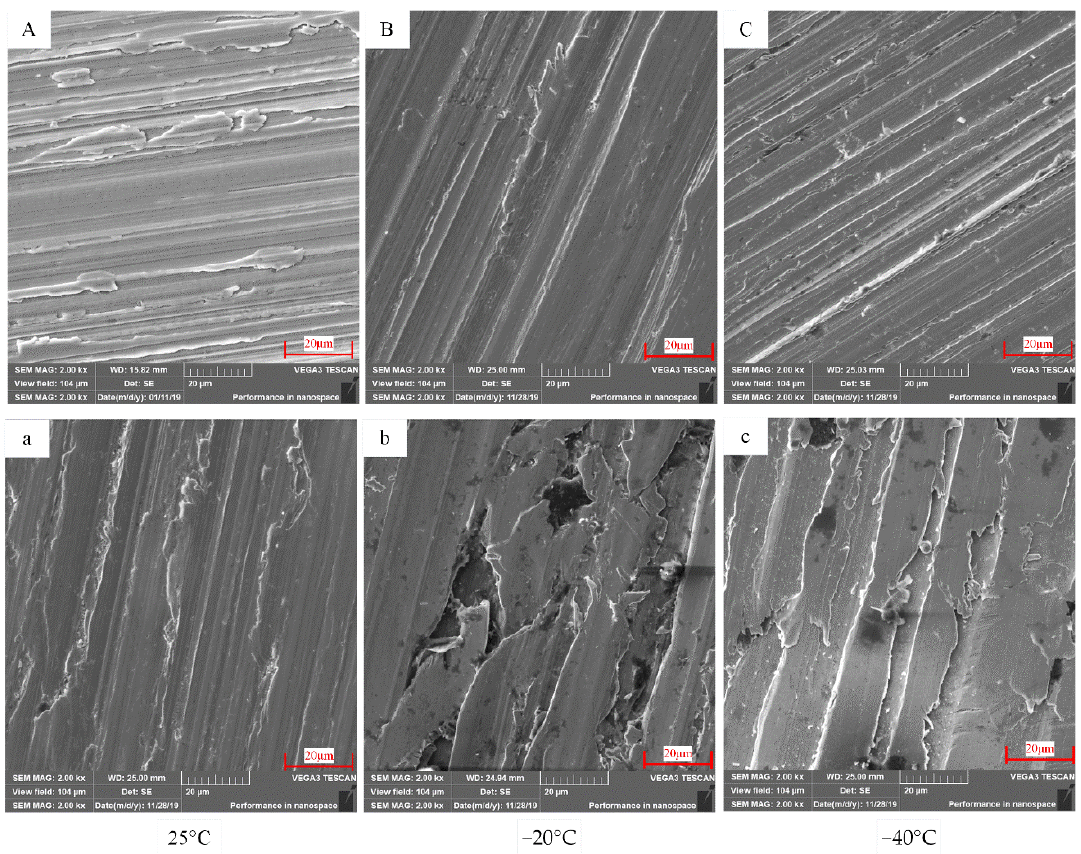
Figure 9. The wear surface morphology of the two material pin samples at different temperatures ( A – C ) are the wear surface morphology of LC2-1 when the test temperatures are 25 °C , −20 °C and −40 °C, respectively; ( a – c ) are the wear surface morphology of QT500-7 when the test temperatures are 25 °C , −20 °C and −40 °C, respectively.